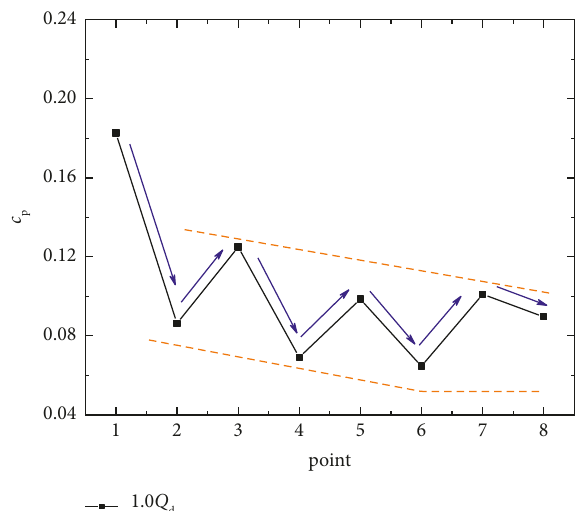
Figure 7: Distribution of pressure spectra at f